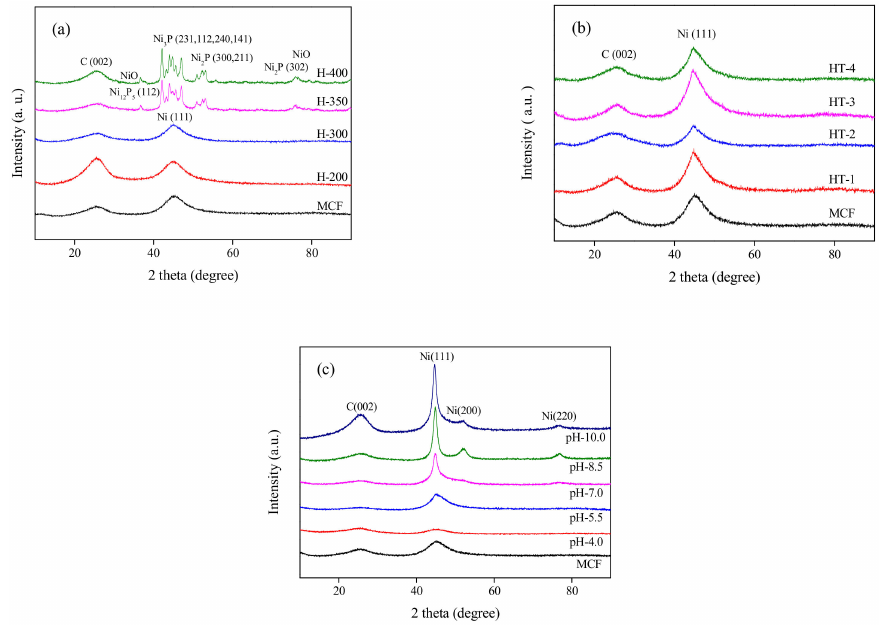
Figure 2. XRD patterns of MCF as a function of the processing parameters: ( a ) heat treatment temperature, ( b ) heat treatment time, and ( c ) pH of the plating